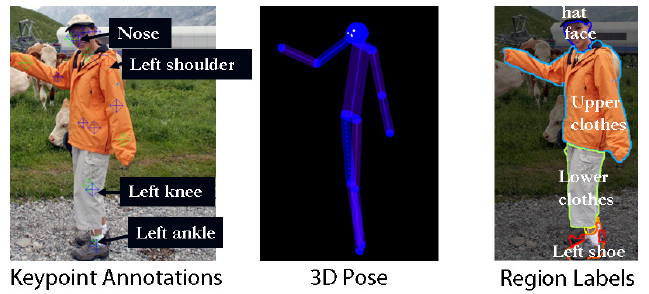
Figure 20. Contents from the H3D dataset. The figure is originally from the website [149].